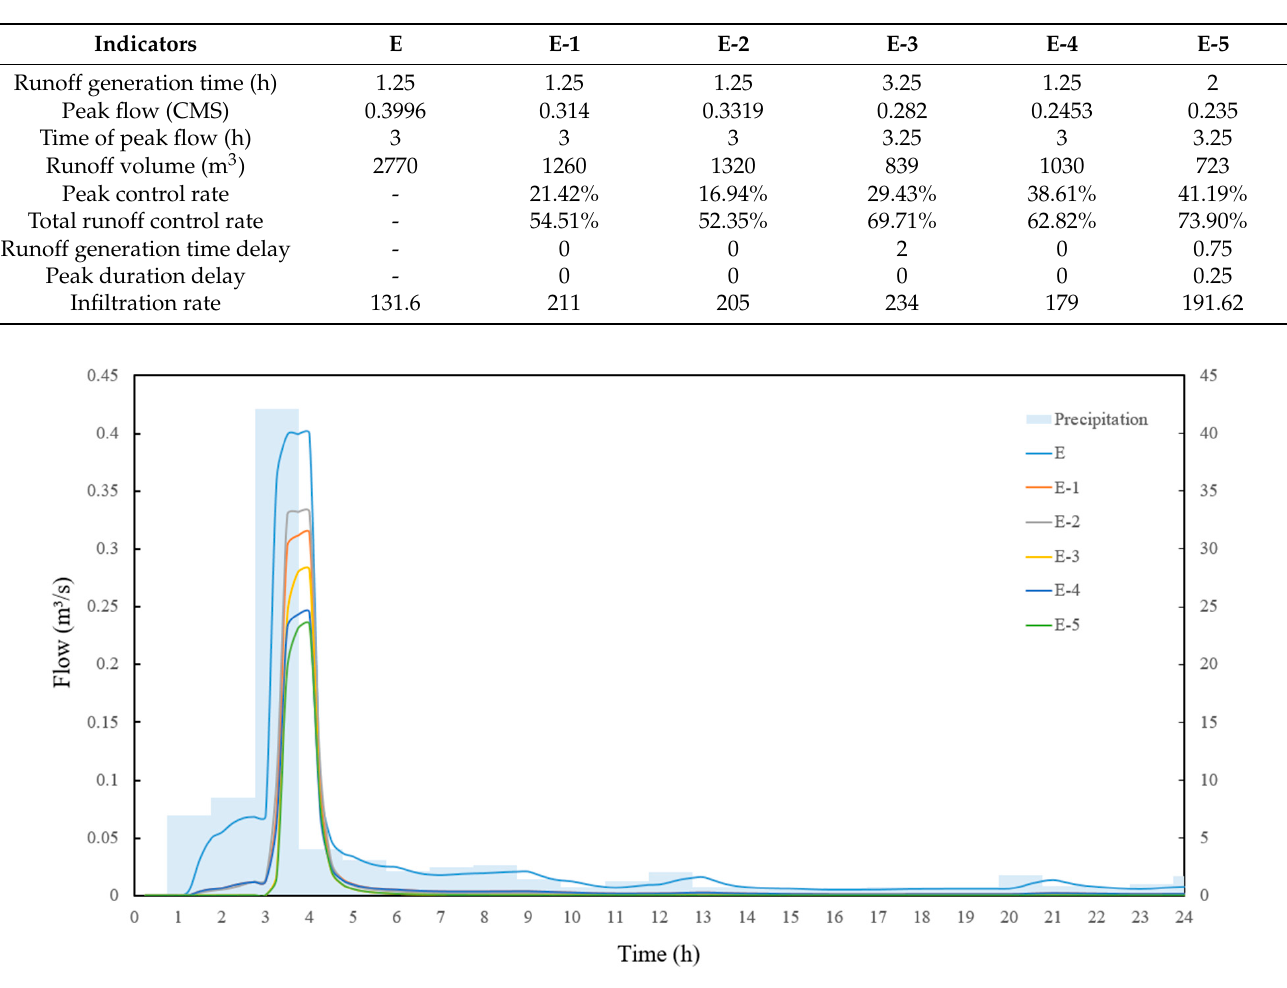
Table 5. Degree of performance improvement for 5 “what-if” scenarios in enclosed mode compared to the current situation.